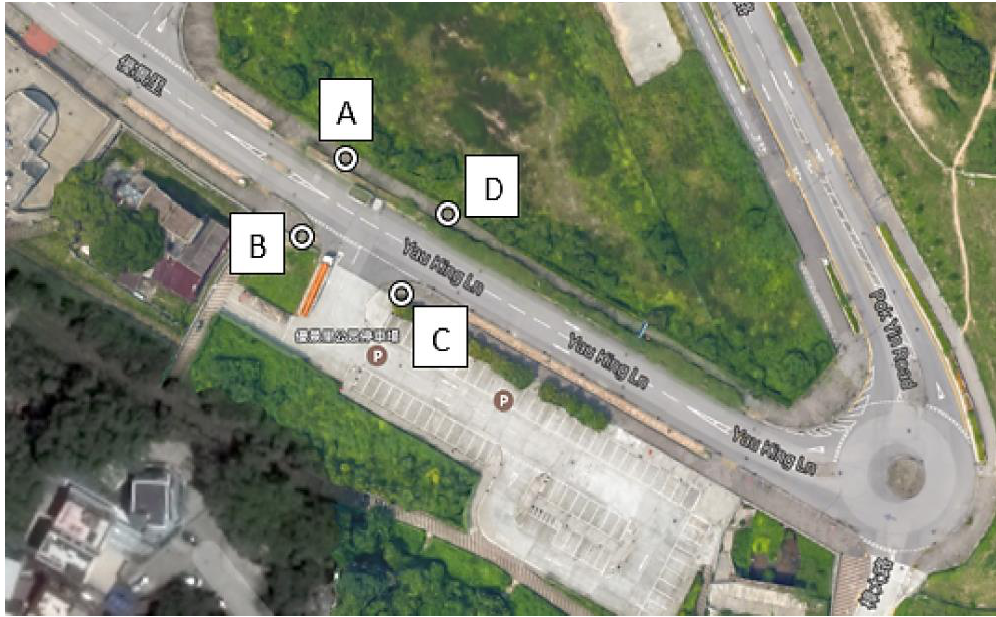
Figure 2. Measurement points A, B, C and D at Yau King Lane in Tai Po, Hong Kong.